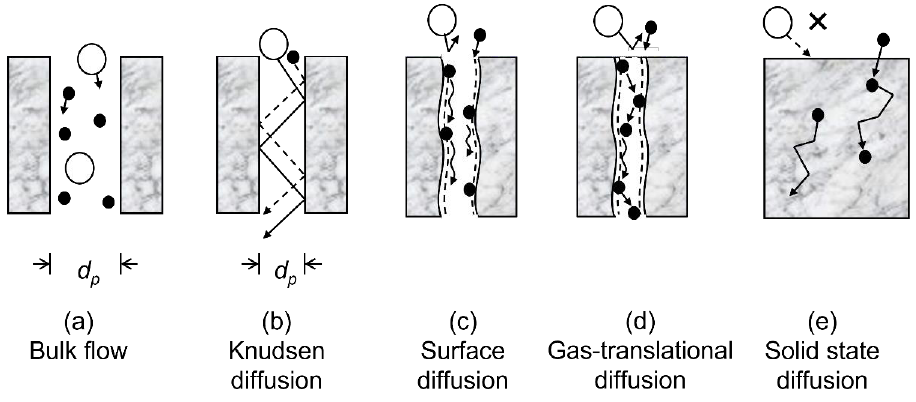
Figure 1. Schematic of gas separation mechanisms.